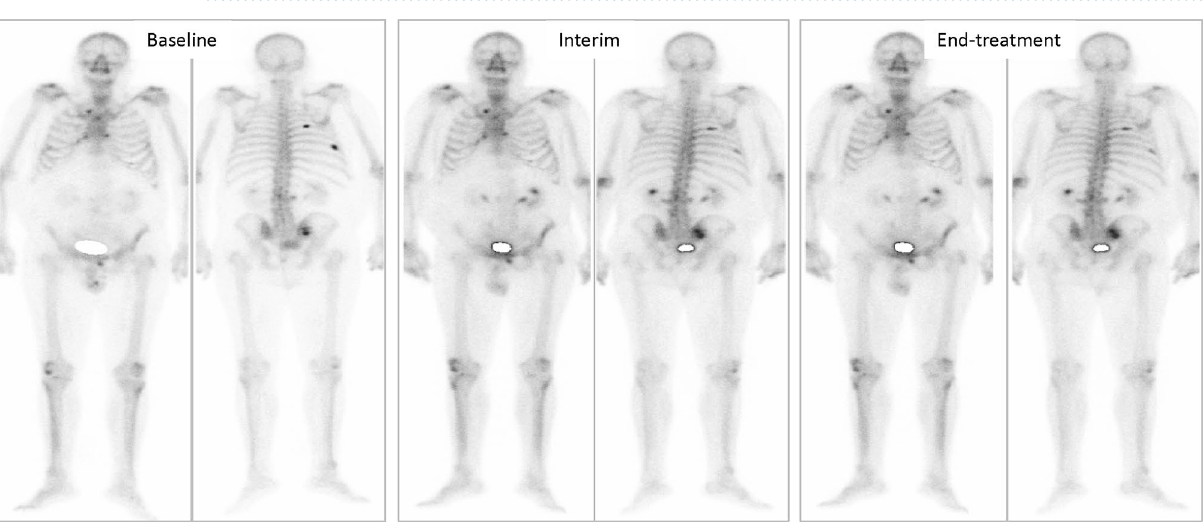
Figure 2. Patient ≠ 1. Baseline total body BS ( A ) and SPECT/CT ( A-1 ) show oligometastatic disease in dorsal spine and right sacrum. Baseline FCH PET/CT ( B ) shows the same pathological locations, without alterations in bone density on CT. Interim total body BS ( C ) showing stability in number of lesions with an increase in osteoblastic activity. Stability regarding the number of lesions on interim FCH PET/CT ( D ) with an increase of density in CT portion (arrowheads). Clinical progression was diagnosed with clinical impairment plus PSA progression, with an increase in size of known lesions on end-treatment BS ( E ). 74 years old man, Gleason 9, 223 Ra in third line, baseline PSA: 32 ng/ml. PFS and OS of 3 and 23 months, respectively.